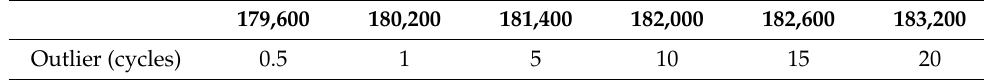
Table 3. Epoch and size of the simulated gross errors.